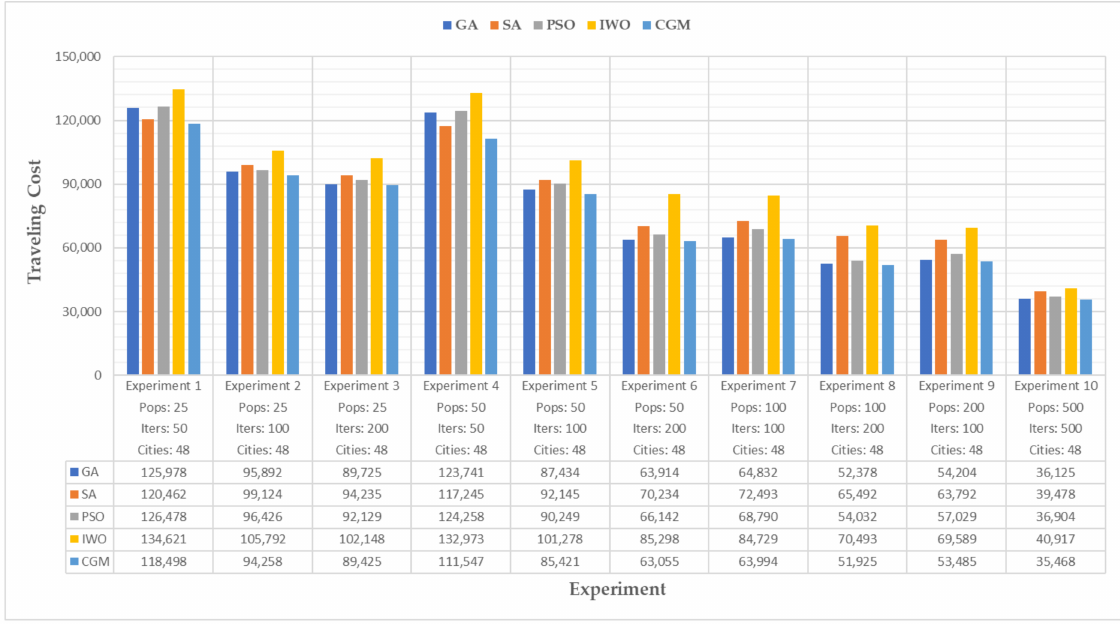
Figure 5. Evaluation results of the traveling salesman problem (ATT48